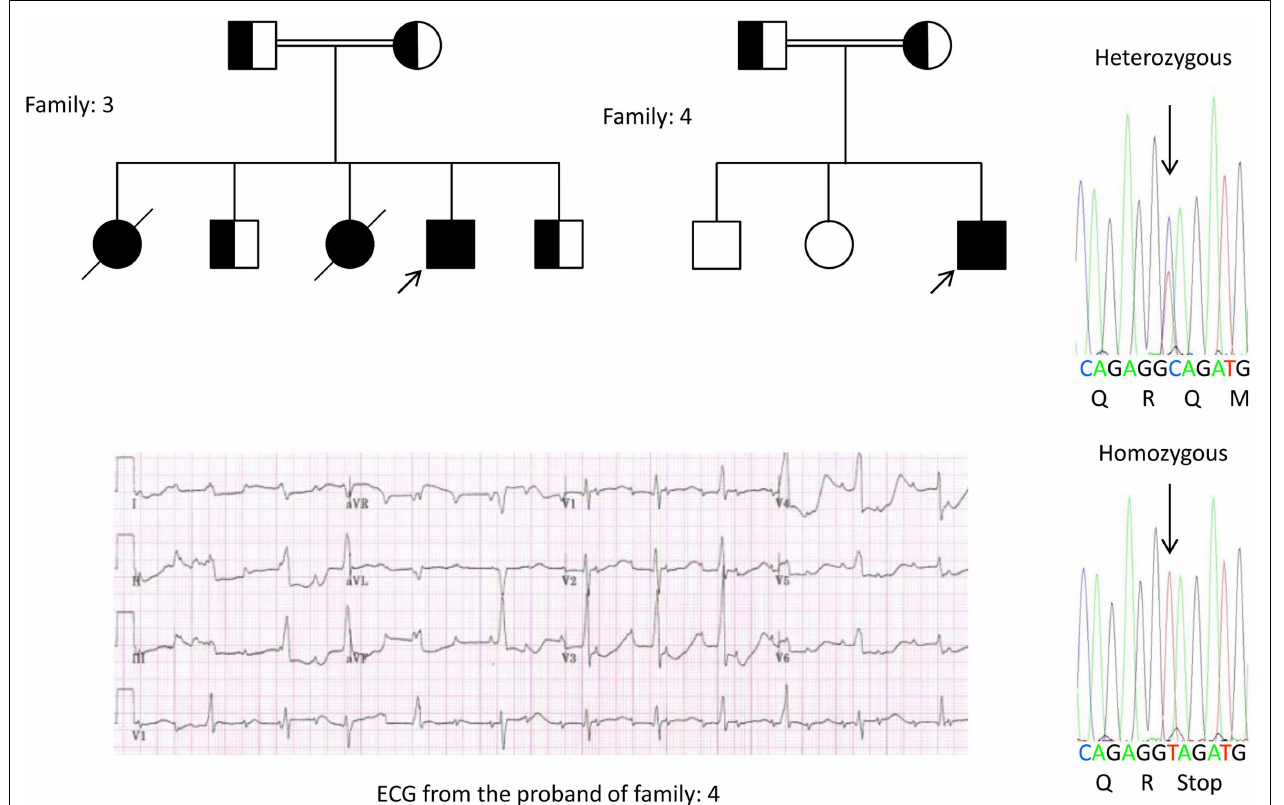
wide complex escape rhythm with very long QTc intervals (QT > 600ms). Mutation, c.3208 C > T (p.Q1070X) in the KCNH2 gene was found in the patients (shown on the right), marked with an